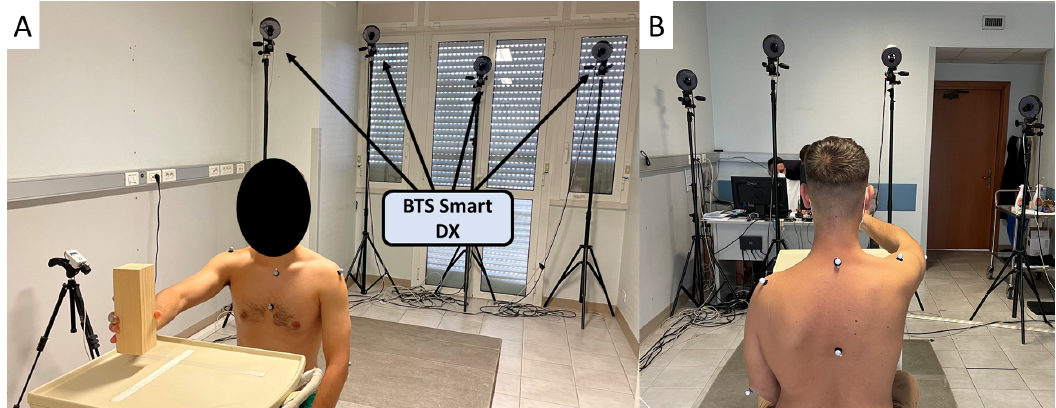
Figure 2. Front and back view of the adopted experimental setup for the acquisition sessions are reported in ( A , B ), respectively. The BTS Smart DX optoeletronic system recorded the motion of the subject while performing working